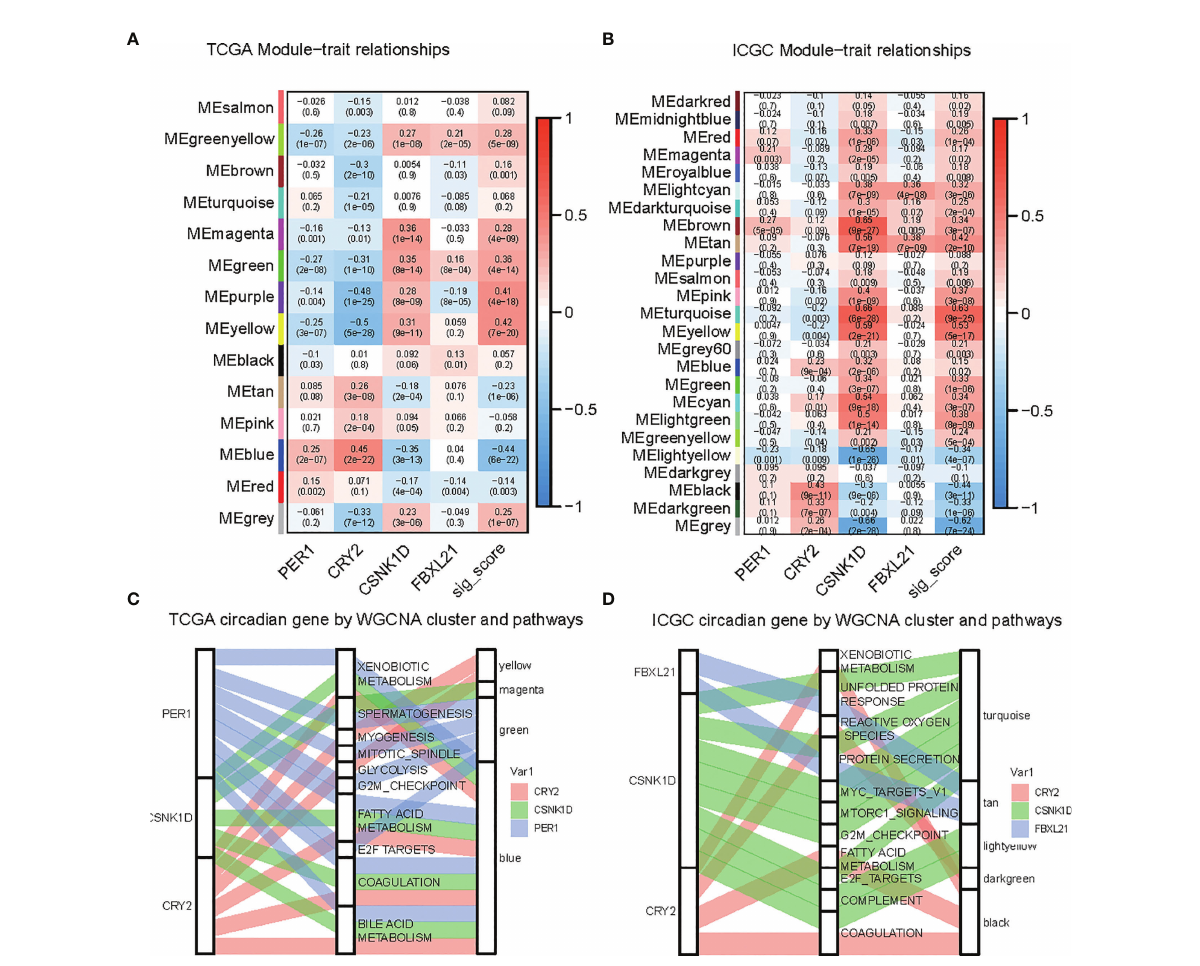
FIGURE 5 Identi fi cation of modules related to circadian genes in the TCGA-LIHC and ICGC datasets. (A, B) Module-trait relationships, where rows represent color modules and columns represent clinical traits (normal and tumor). Cells represent the corresponding correlation and P-value. (C, D) Sankey plot indicates the association between the circadian gene, hallmark pathway, and WGCNA